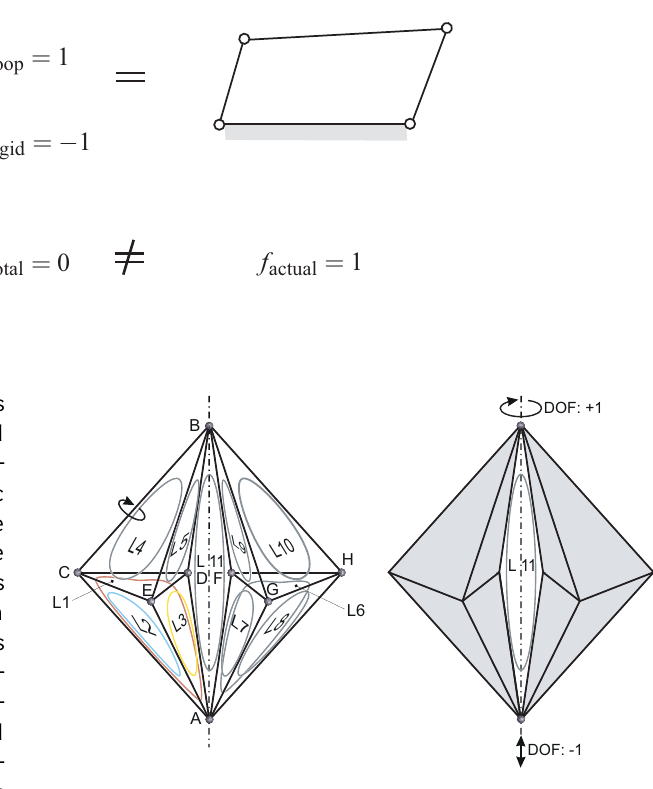
Figure 2. The “double-banana”